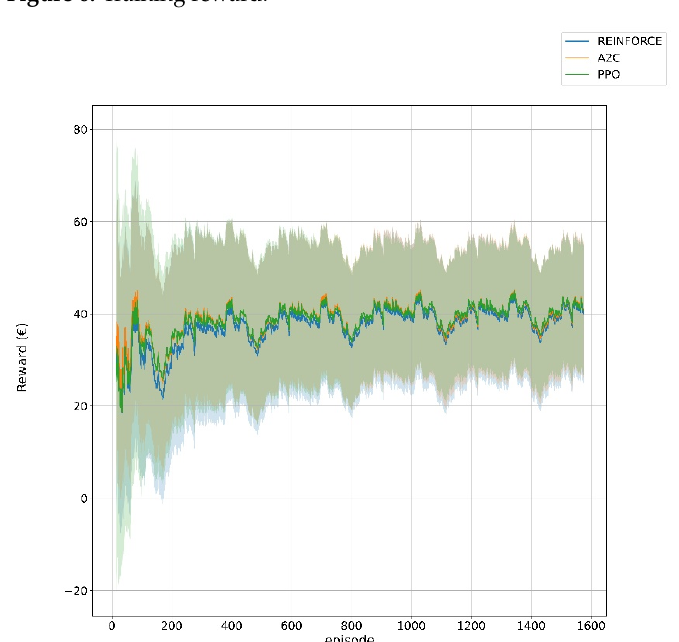
Figure 7. Training reward with standard deviation included.